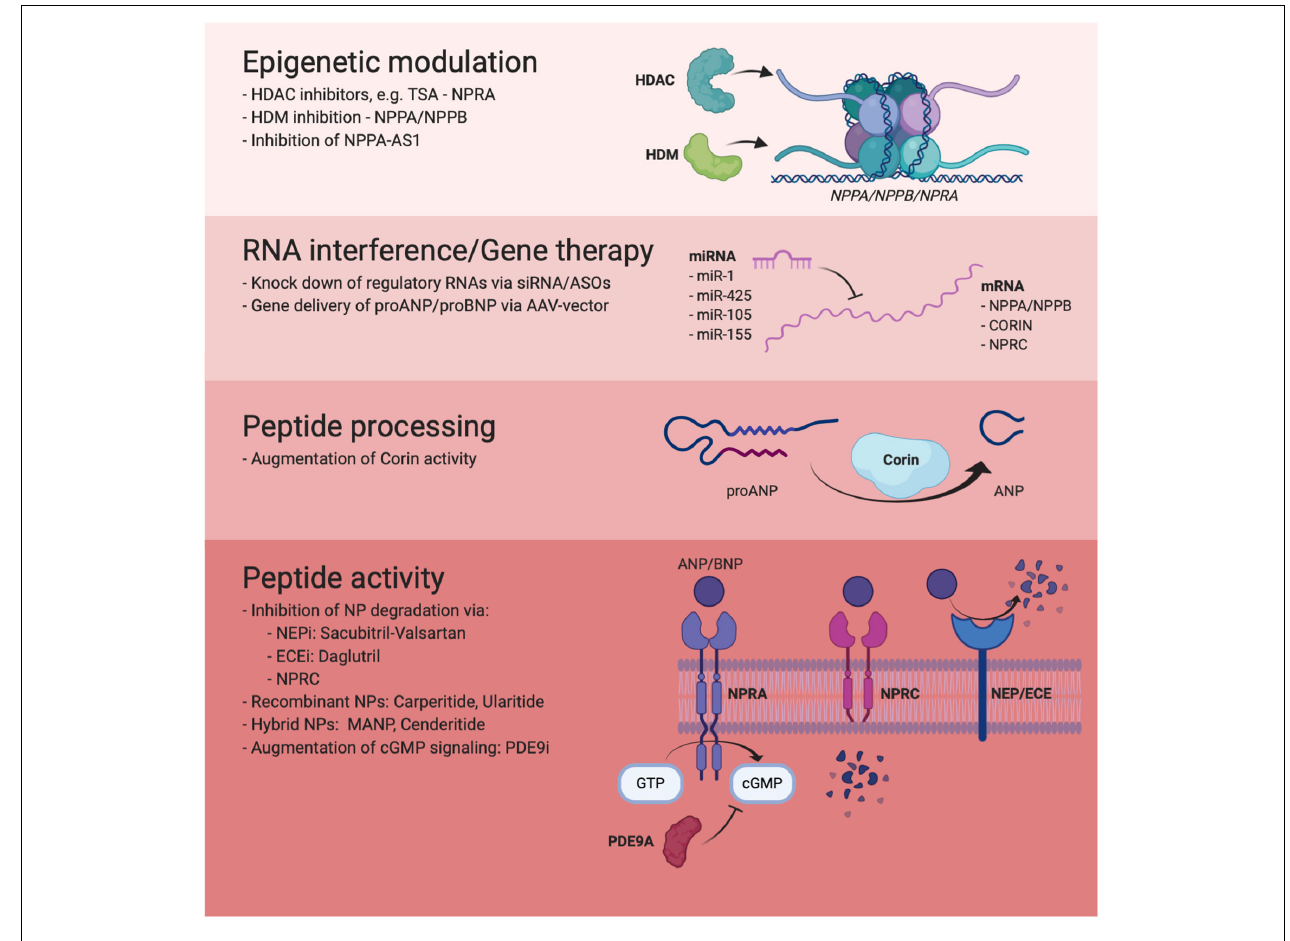
FIGURE 1 | Overview of novel approaches to therapeutic NP augmentation included in this